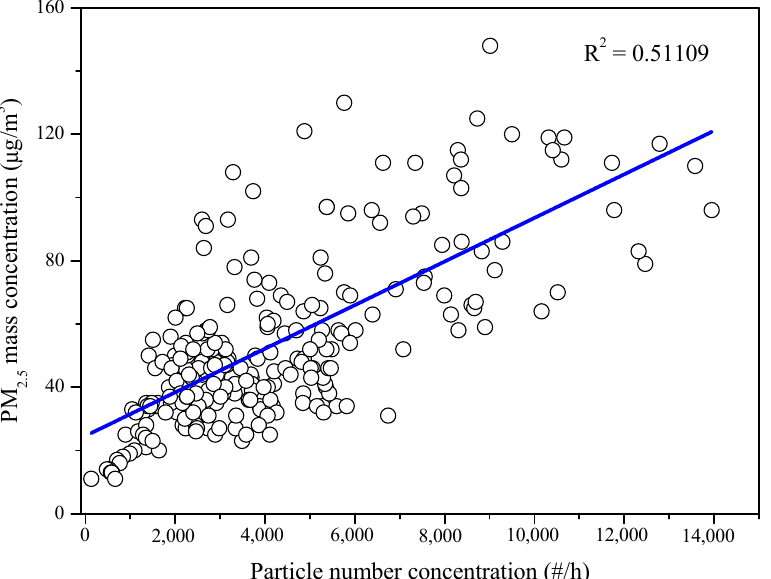
Figure 7. Correlation between the number concentration of ambient particles collected using a SPAMS and PM 2.5 mass concentration.